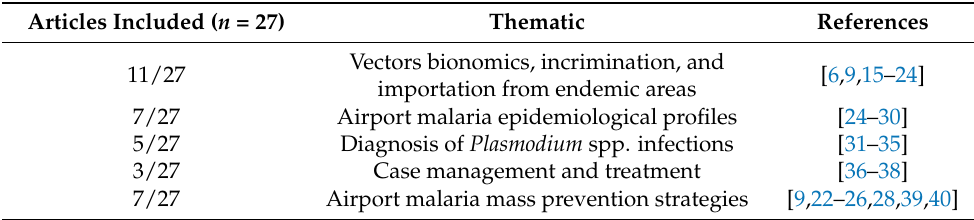
Table 1. Articles included in the